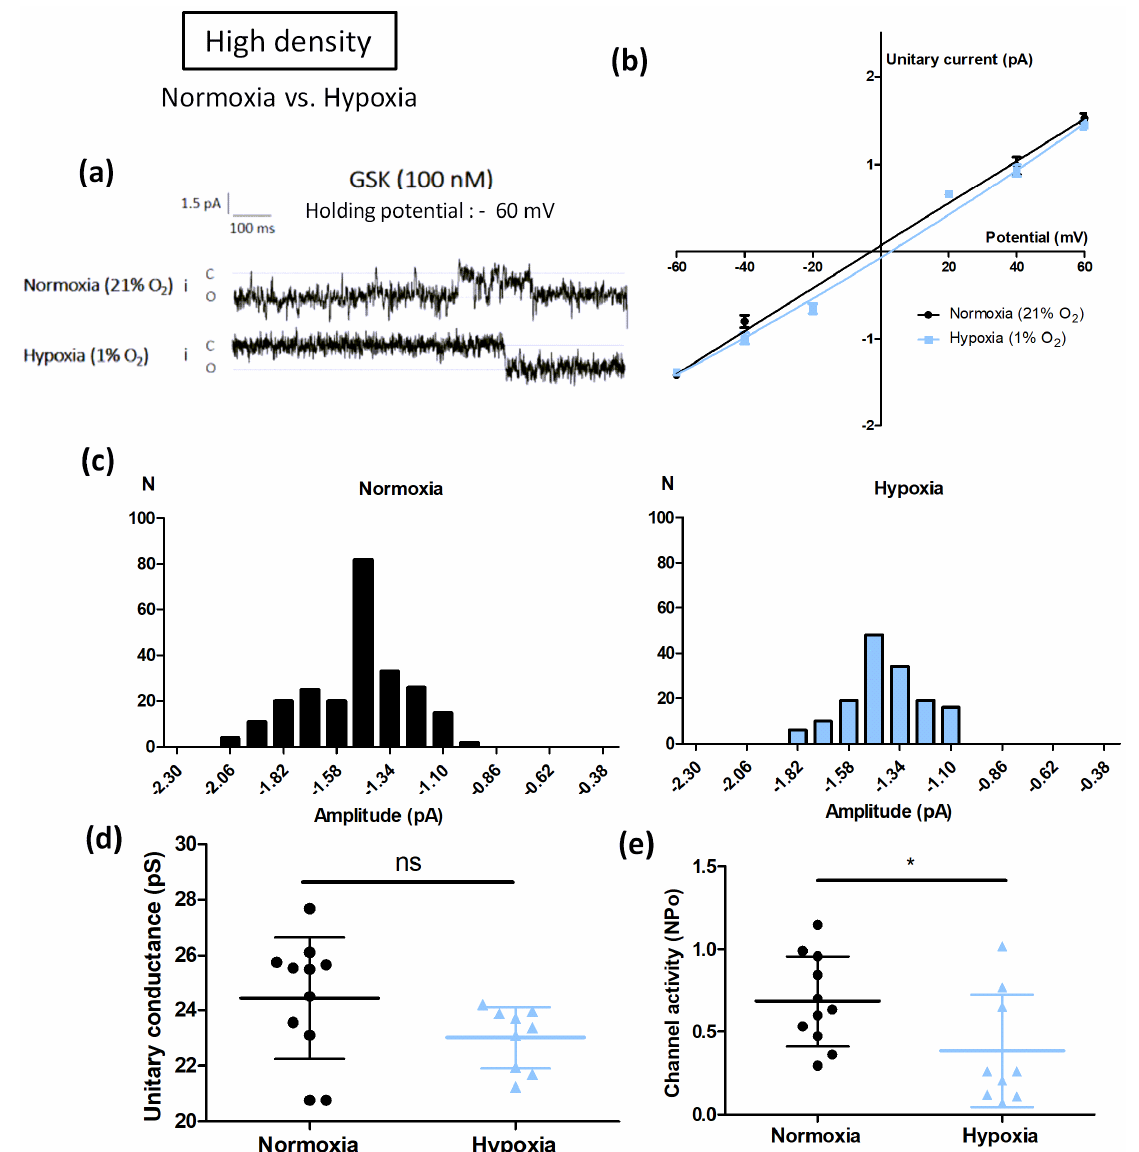
Figure 5. Cell confluence alters hypoxia-induced TRPV4 current potentiation in transiently TRPV4- transfected HEK293T (HEK-TRPV4) cells. ( a ) Representative records of current traces (patch clamp; cell-attached configuration at − 60 mV holding potential, assuming a resting potential of 0 mV) recorded in HEK-TRPV4 cells cultured under normoxia (21% O 2 ) or hypoxia (1% O 2 ) for 48 h at high cell confluence (3 × 10 5 cells/cm 2 ). The letters c and o indicate the closed and open channel states, respectively. ( b ) Unitary current (i)/potential (V) curves, ( c ) corresponding amplitude histograms shown at − 60 mV, ( d ) unitary conductance, and ( e ) channel activity (NPo), determined at a holding potential of − 60 mV in presence of the TRPV4 agonist GSK1016790A (100 nM). Data are expressed as mean value ± SD. Significant difference is indicated by one asterisk when p < 0.05 and ns indicates a non-significant difference, Mann–Whitney test.